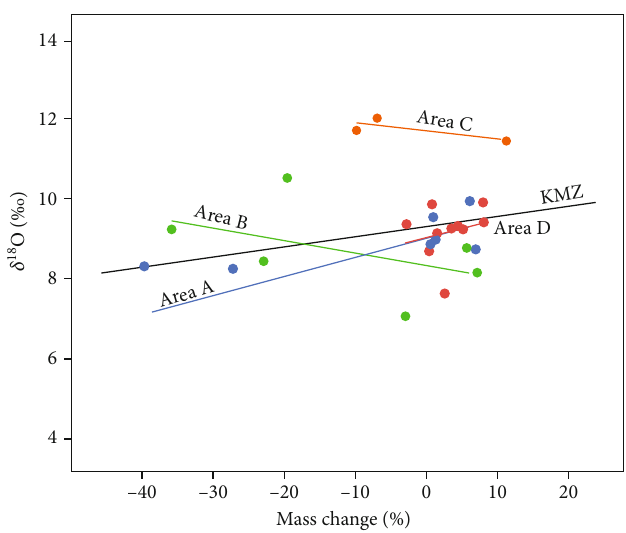
Figure 13: δ 18 O against mass change show weak